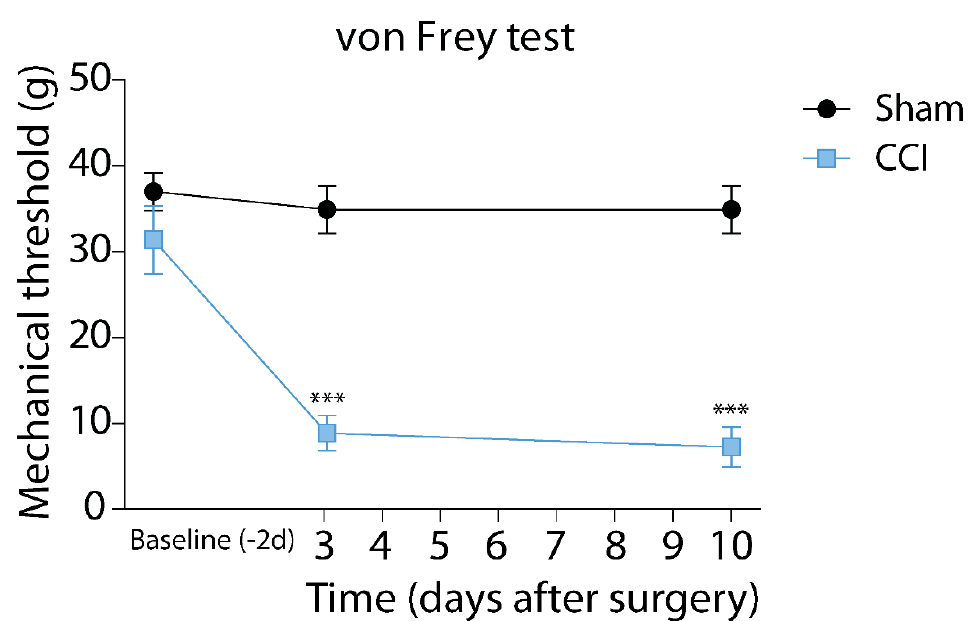
Figure 1. Von Frey mechanical thresholds in the CCI neuropathic pain model. *** p < 0.001